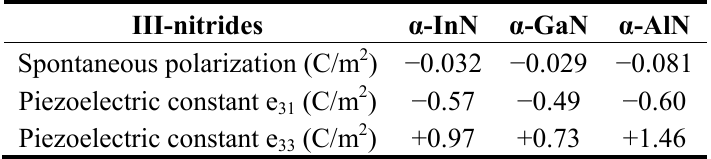
Table 1. Spontaneous polarization and piezoelectric constant values for III-nitrides, taken from